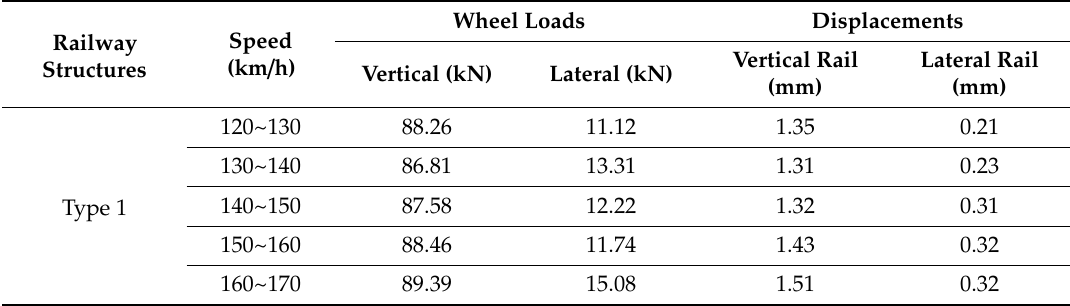
Table 8. Average values of maximum dynamic response by passing train for concrete track structures. Railway